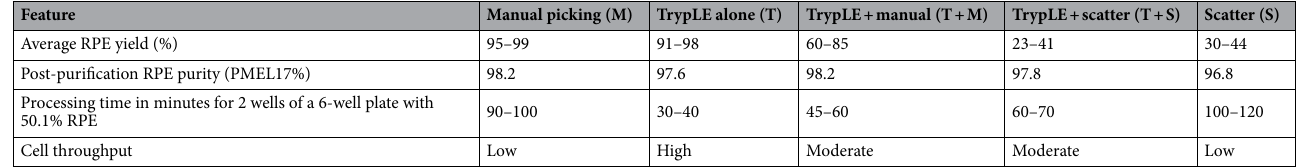
Table 1. Comparison of RPE purification